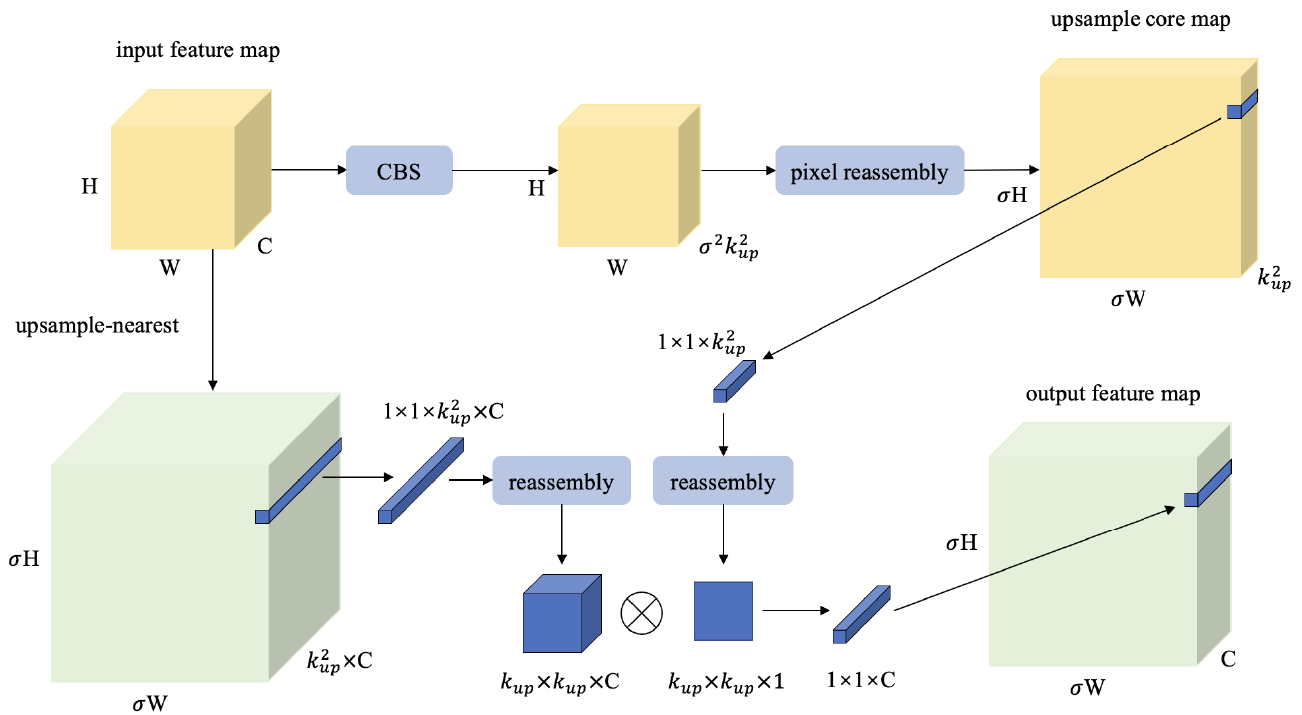
Figure 3. Structure of CAU-Lite.